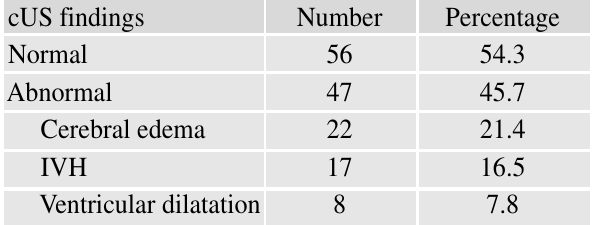
IVH, intraventricular hemorrhage (cid:13) The cranial ultrasound (cUS) findings of